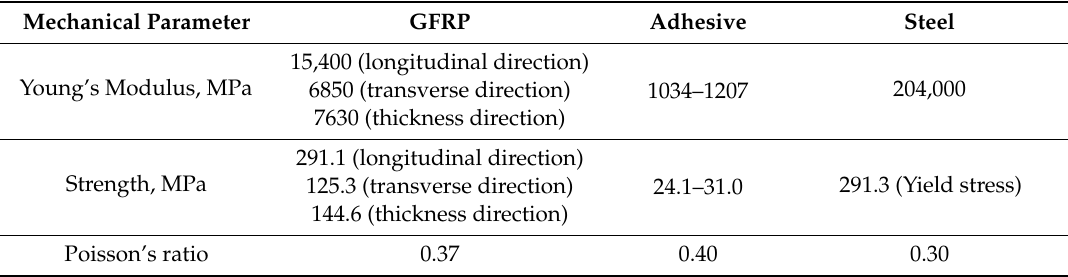
Table 1. Mechanical properties of glass fiber-reinforced polymer (GFRP), adhesive, and